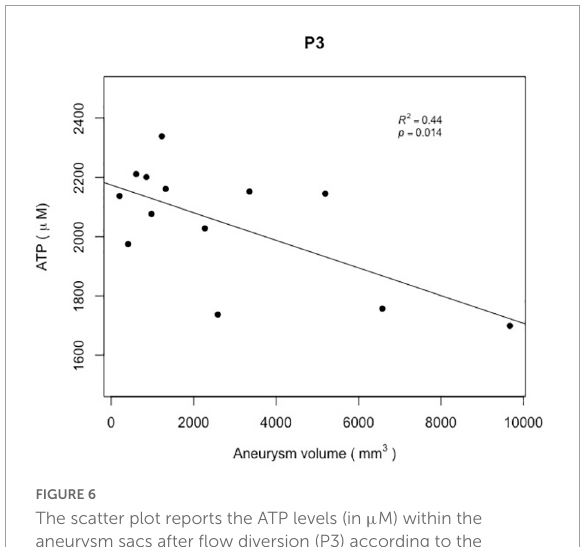
FIGURE6 The scatter plot reports the ATP levels (in µ M) within the aneurysm sacs after flow diversion (P3) according to the aneurysm volumes (in mm3). A significant correlation was observed between the ATP levels within the aneurysm sacs after flow diversion (P3) and the aneurysm volumes ( R 2 = 0.44; p =